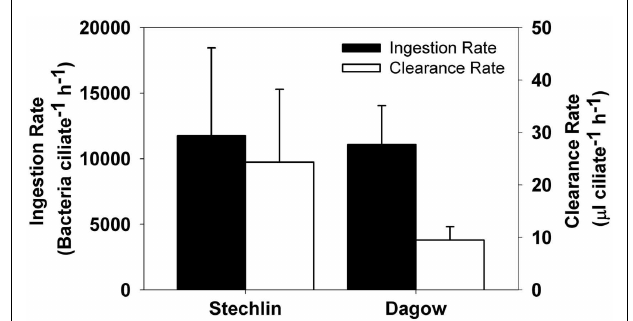
FIGURE 6 | Estimated ingestion rates (black bars, left axis) and clearance rates (white bars, right axis) of the peritrich ciliate Epistylis sp. when attached to the calanoid copepod Eudiaptomus gracilis collected from Lake Stechlin and Lake Dagow (mean ± SD, n =